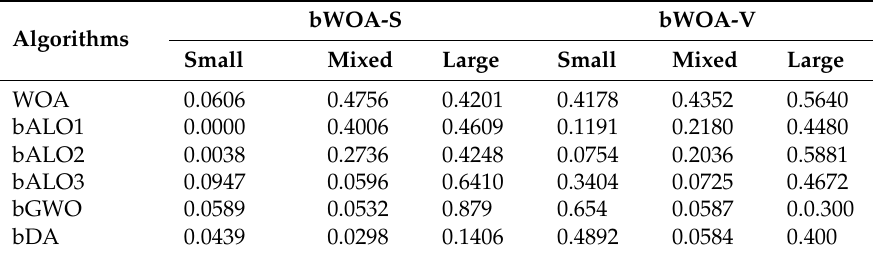
Table 15. The Wilcoxon test for the average fitness obtained by the compared algorithms. bWOA-S bWOA-V Algorithms Small Mixed Large Small Mixed Large WOA 0.0606 0.4756 0.4201 0.4178 0.4352 0.5640 bALO1 0.0000 0.4006 0.4609 0.1191 0.2180 0.4480 bALO2 0.0038 0.2736 0.4248 0.0754 0.2036 0.5881 bALO3 0.0947 0.0596 0.6410 0.3404 0.0725 0.4672 bGWO 0.0589 0.0532 0.879 0.654 0.0587 0.0.300 bDA 0.0439 0.0298 0.1406 0.4892 0.0584